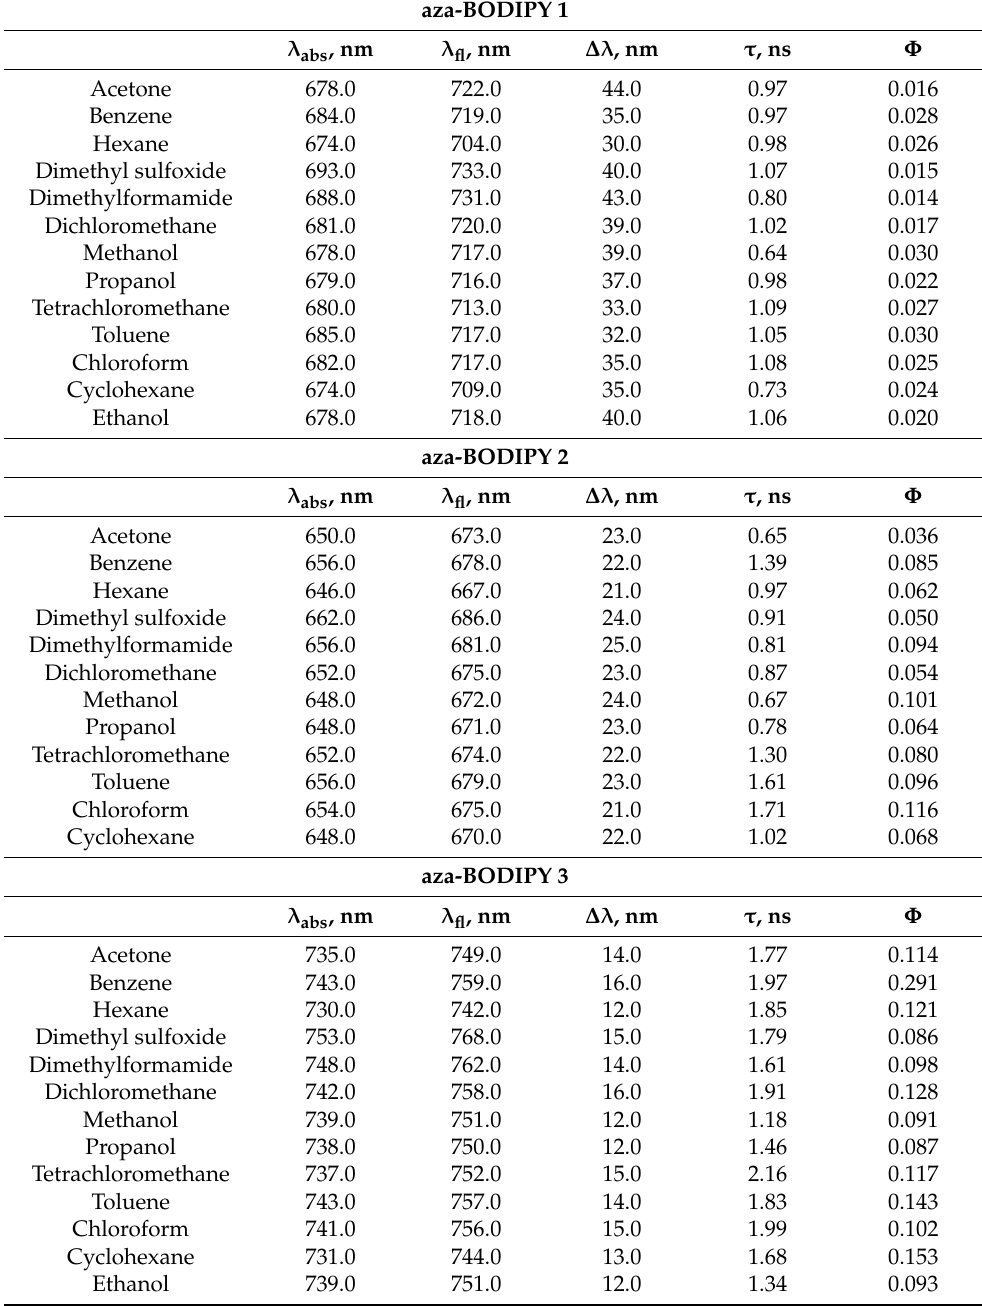
Table 2. Spectral characteristics of aza-BODIPYs 1–3 in individual organic solvents: λ abs —absorption maximum wavelength, nm; λ fl —wavelength of fluorescence maximum, nm; ∆ λ —Stokes’ shift, nm; τ —fluorescence lifetime at 293 K, ns, Φ —fluorescence quantum yield. Fluorescence was excited at 600